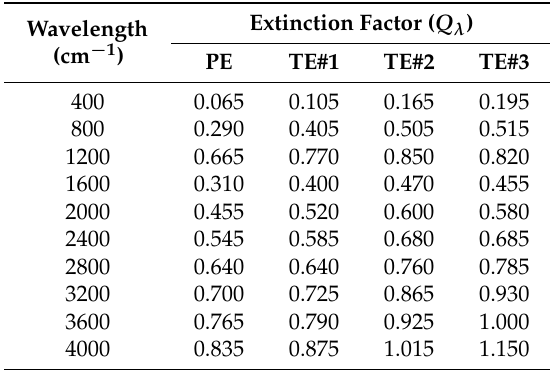
Table 2. Q λ of PE and TE#1–TE#3 at 400–4000 cm − 1